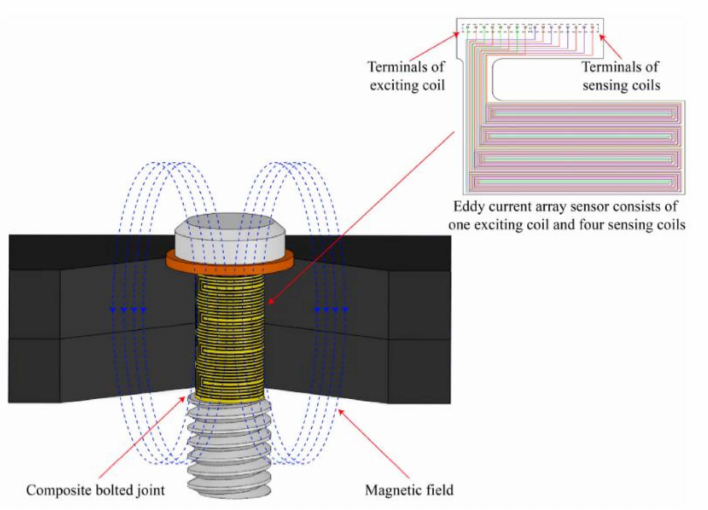
Figure 12. Operating principle of eddy current sensing method